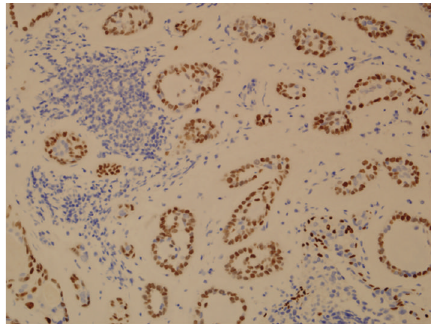
Figure 2: Immunohistochemistry for p63 was positive, demonstrat- ing the presence of myoepithelial cells ( ×